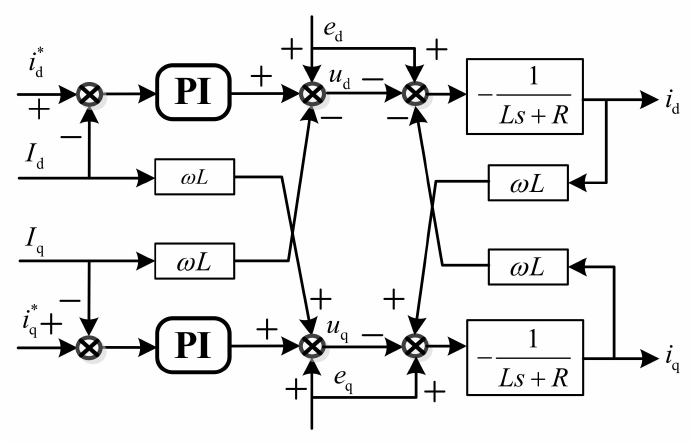
Figure 2. Schematic diagram of current decoupling